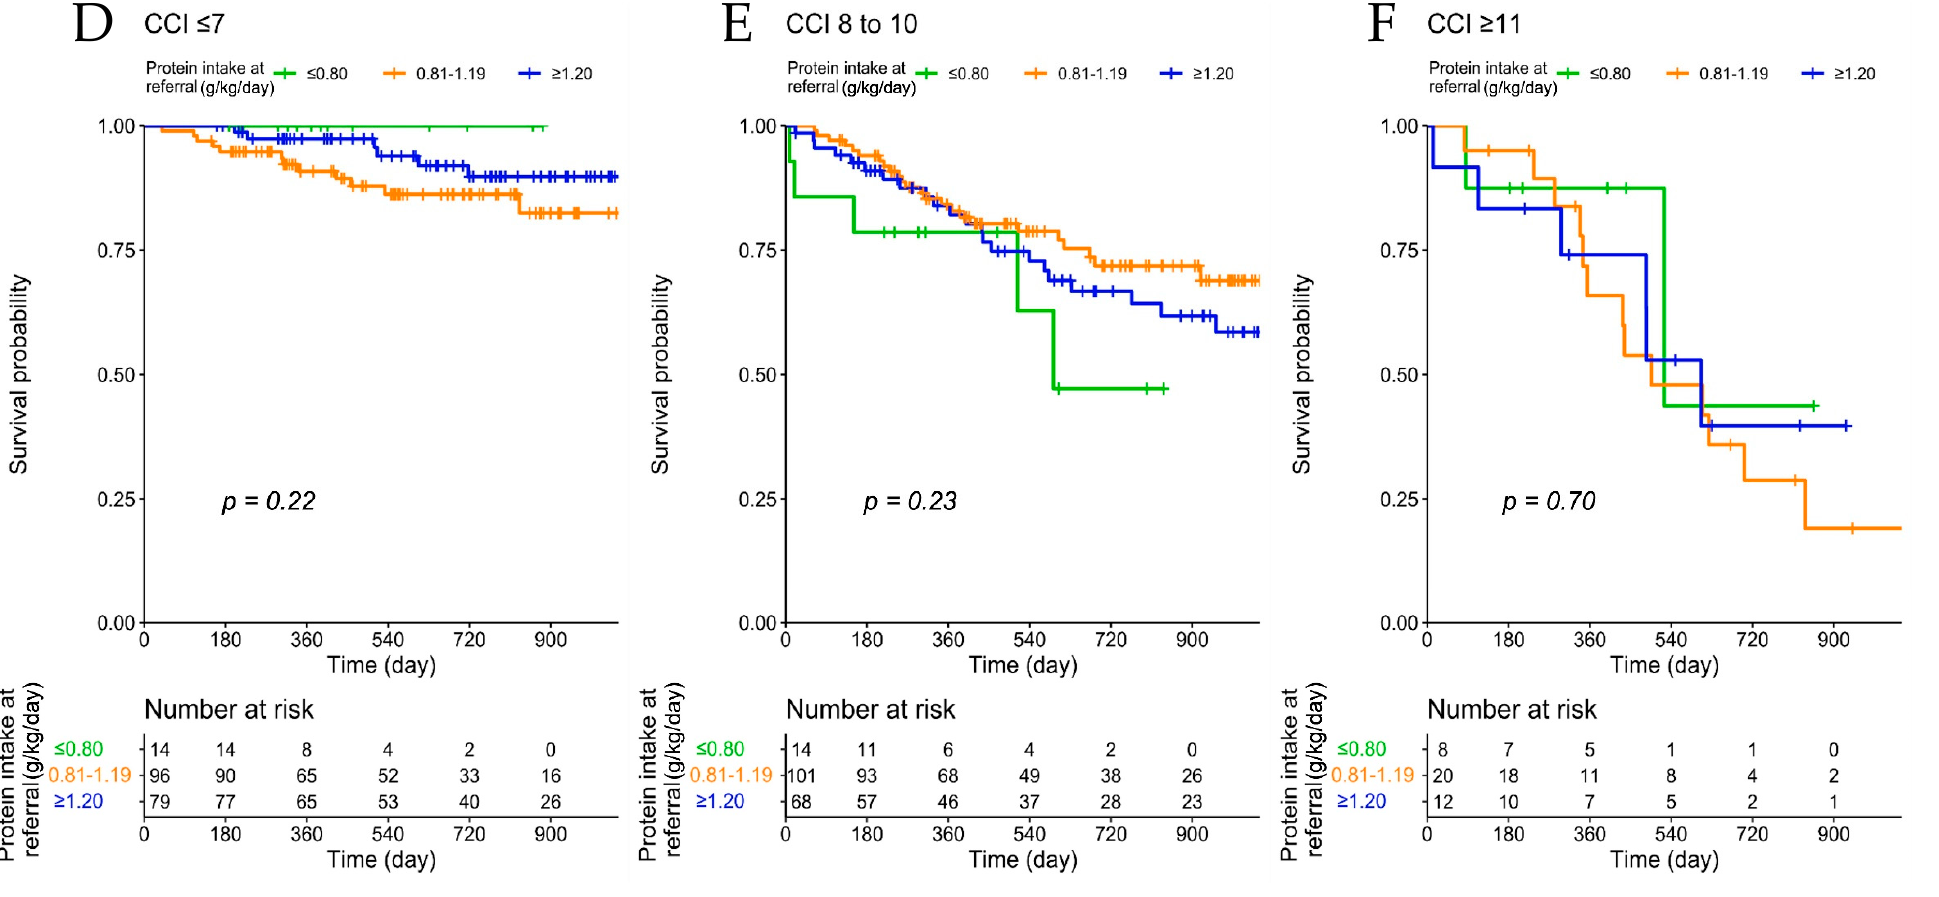
Figure 2. Patient survival according to protein intake at baseline, across age groups ( A – C ) and Charlson Comorbidity Index ( D – F ).